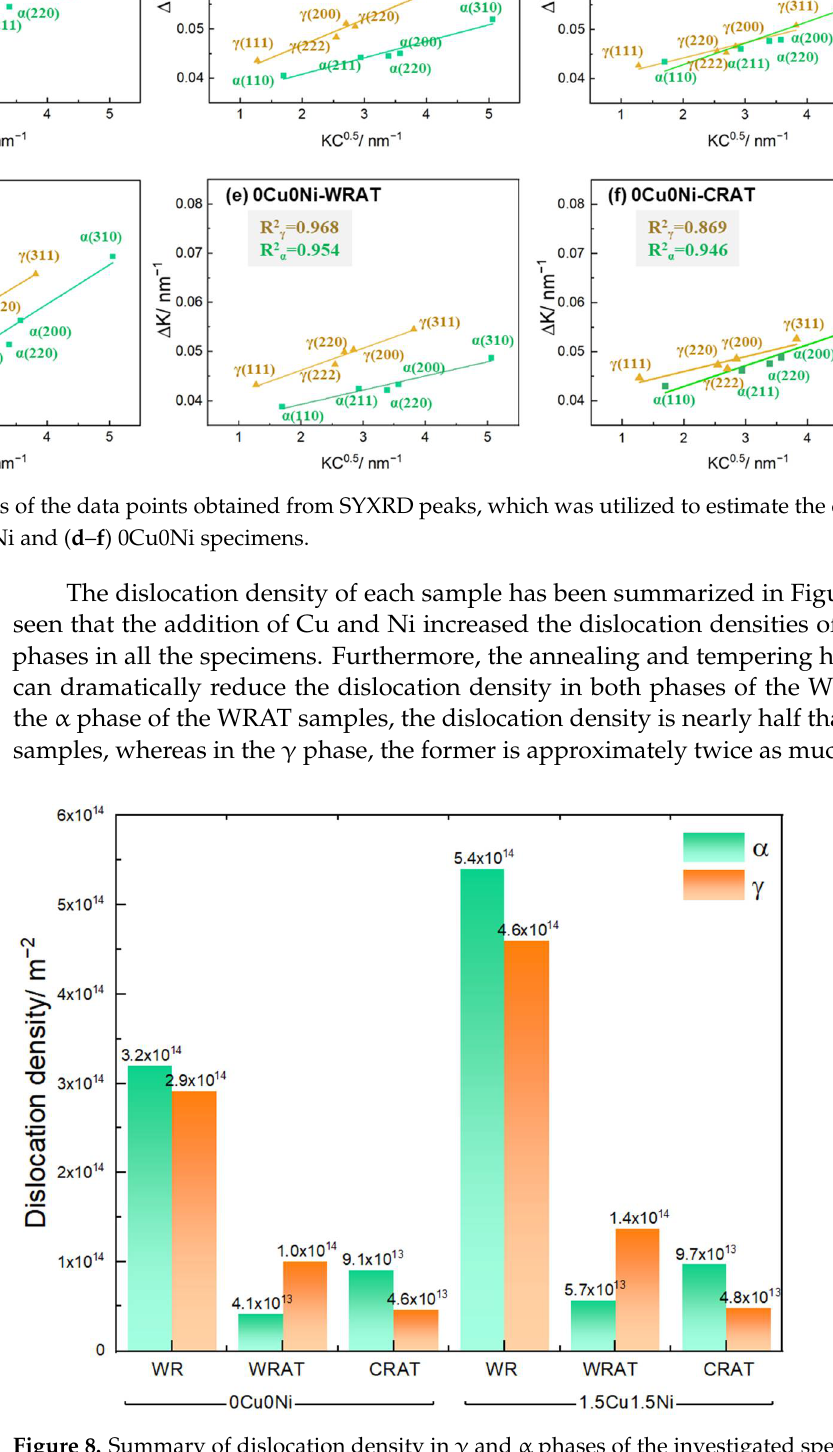
Figure 8. Summary of dislocation density in γ and α phases of the investigated specimens.